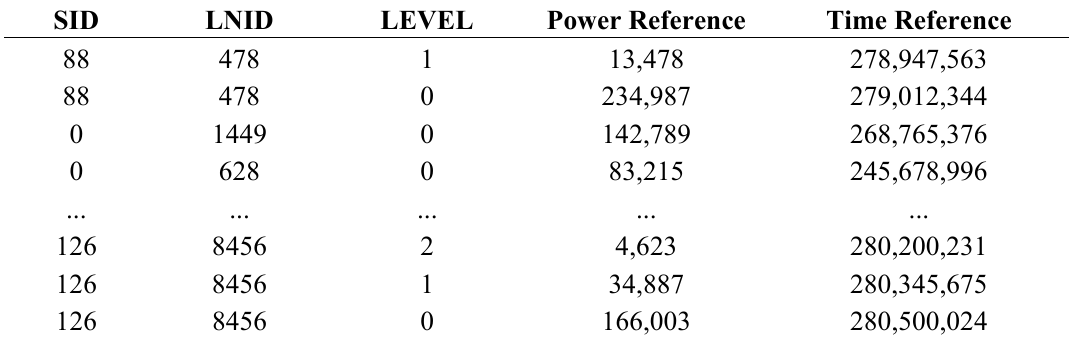
Table 5. Power information stored by the line detection